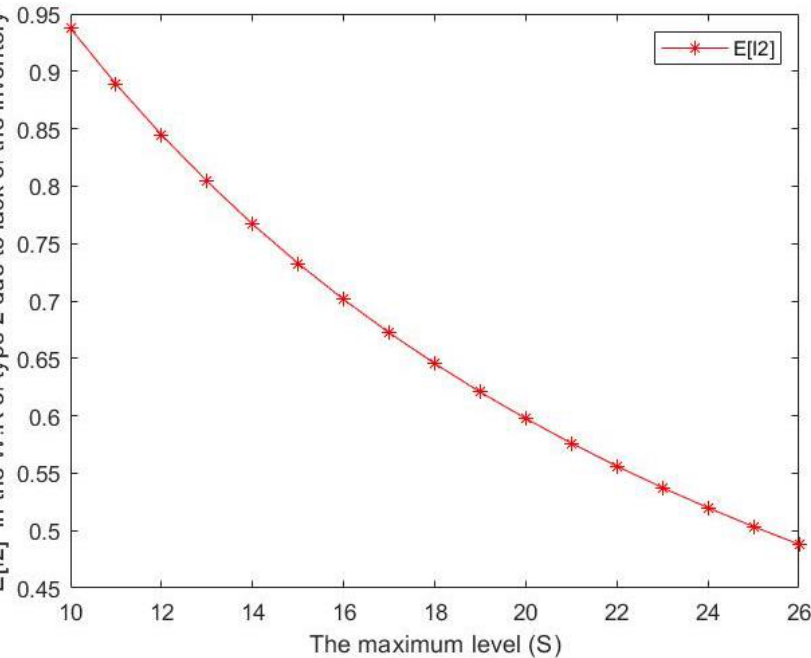
Figure 6. Effect of S on expected number of type 2 customers in the waiting room for type 2 due to lack of